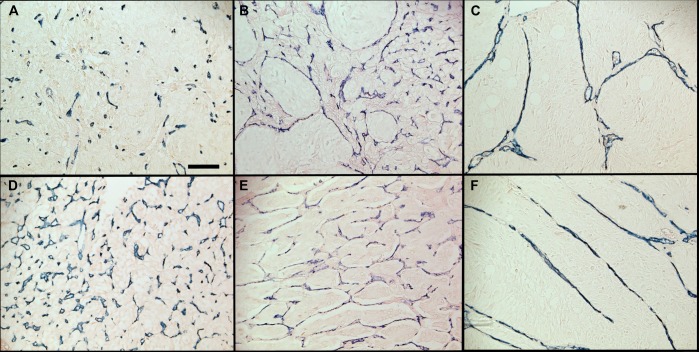
Vascular architecture in PCC/PGLs.Immunostaining of blood vessels with anti-CD34 reveals a homogenously distributed vascular pattern in benign tumors (A, D), while malignant tumors display irregularity (B) and vascular structures forming arcs (C), networks (E) and parallels (F). All panels are at the same magnification. Scale bar = 100μm.